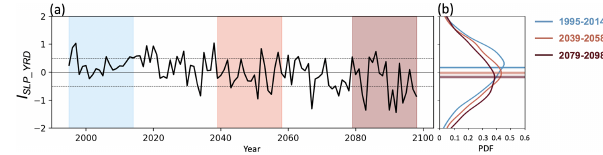
Figure 10. (a) Time series of winter mean I SLP_YRD from histori- cal (1995–2014) and future (2015–2098, SSP3-7.0) simulations of UKESM1 in the CMIP6 archive. Blue, orange and red areas repre- sent present day (1995–2014), mid-century (2039–2058), and end of the century (2079–2098), respectively. (b) Frequency distribu- tions of daily mean I SLP_YRD during winter over each period. The horizontal lines and shading represent the mean values and the as- sociated 95% confidence intervals,